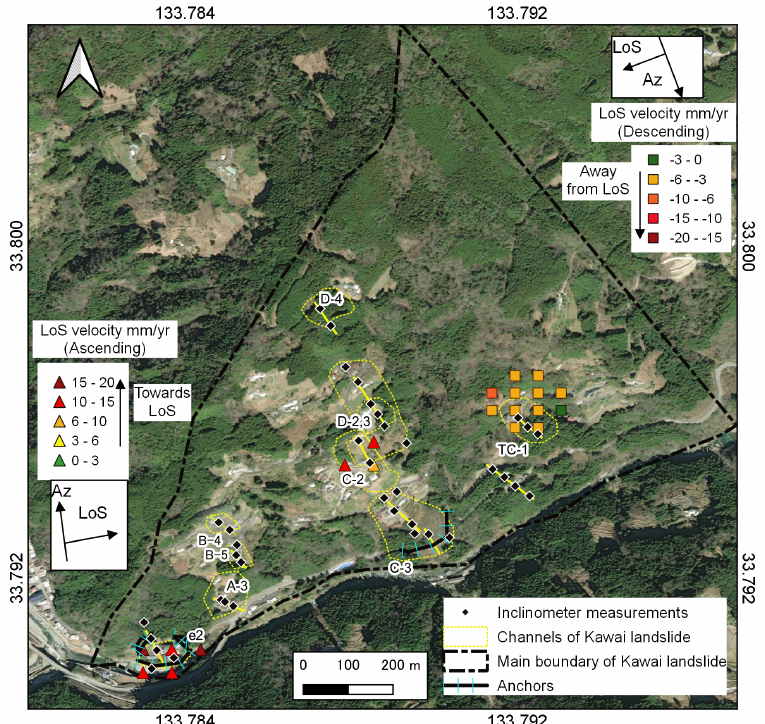
Figure 8. Detailed layout of the Kawai area showing the InSAR and ground inclinometer measure- ments. The diamond symbols are ground inclinometer readings, whereby the horizontal movement and tilting of the sliding surface during the Kawai landslide were measured along the direction of the slope. The colored triangular symbols indicate the velocities obtained from the S-1 ascending track (positive values captured motion toward the LoS), while the S-1 velocity values of the descending track (negative values indicate the same movement away from the LoS) are shown as